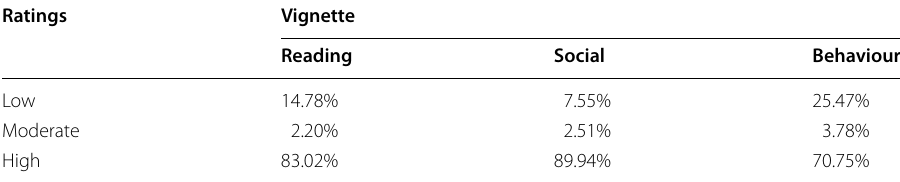
Table 2 Vignette acceptability rating according to mean item score (TEI-SF)